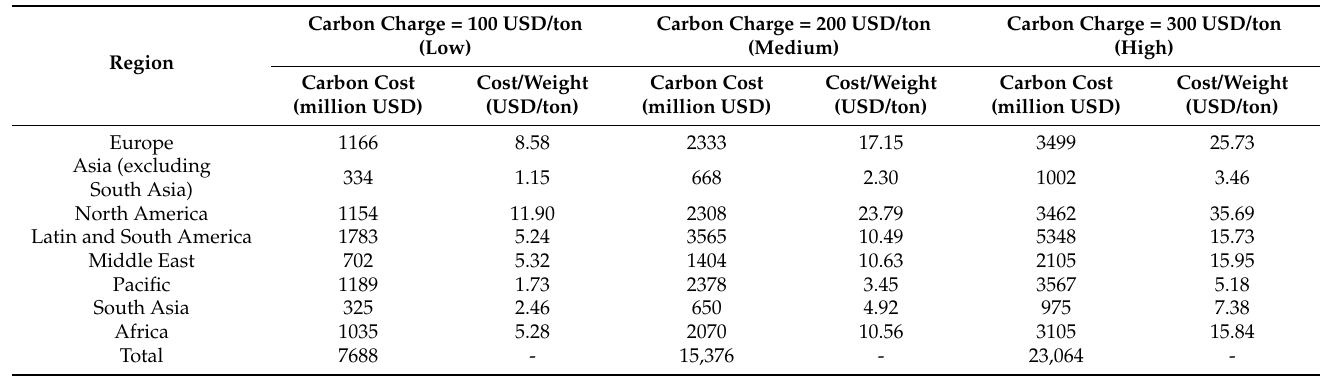
Table 3. Estimated carbon costs from dry bulk trade shipping in China, 2021.